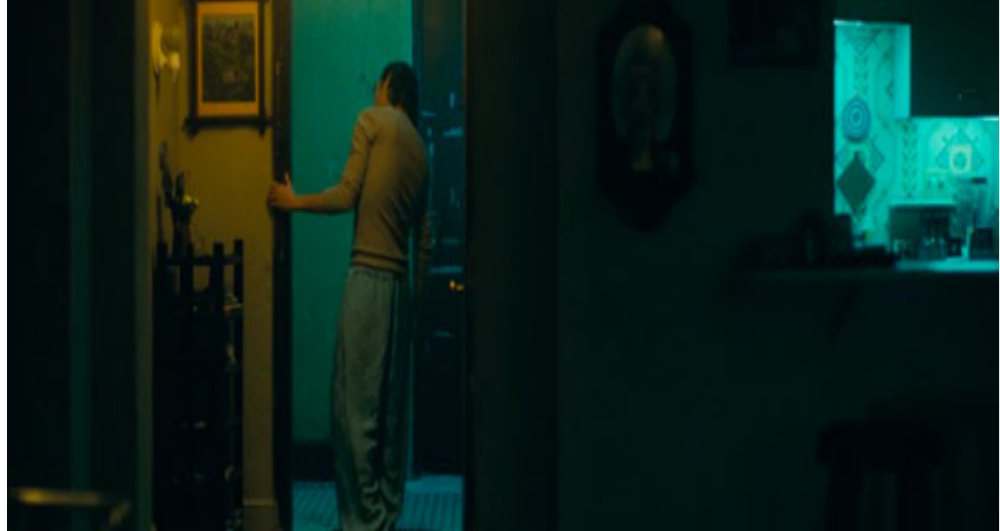
Figure 50 The composition of this shot at the end of the Journal scene amplifies Arthur’s isolation, with dominant negative space and short siding at play